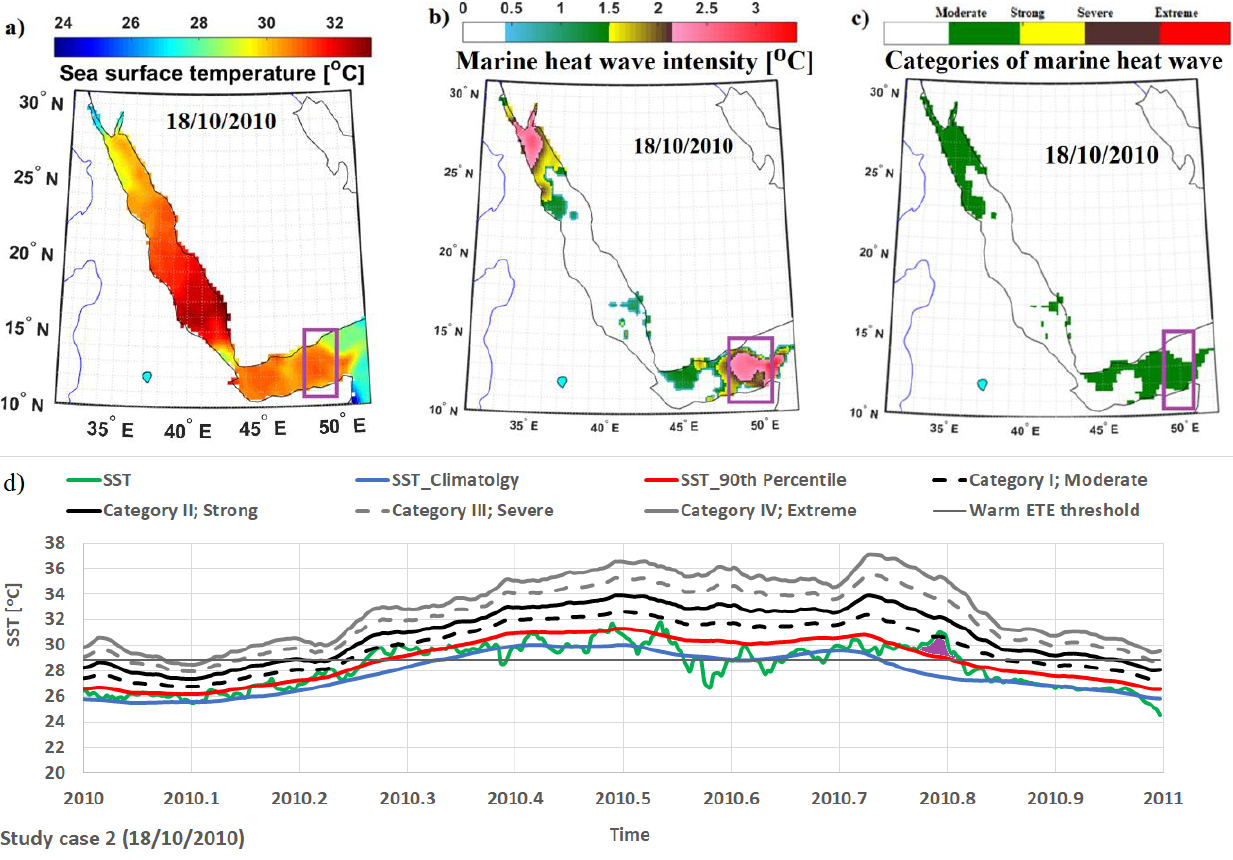
Figure 12. Representative of the MHW event (study case 2 ) showing the sea surface temperature ( a ), intensity [°C] of marine heat wave event ( b ) and category of that event ( c ) at the peak of the event and the time series during the event’s year ( d ), spatially averaged over an area around the maximum intensity grid, which is shown in bubbles.